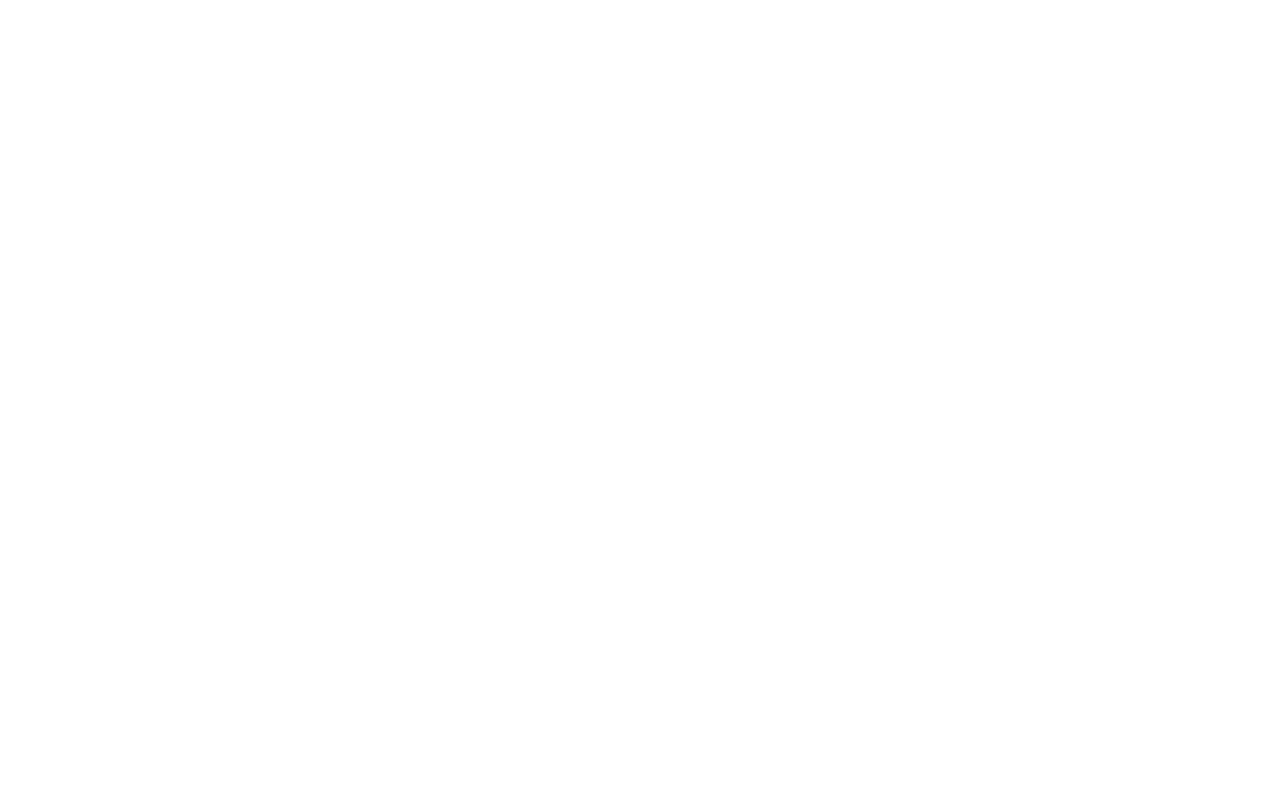
Frontiers in Surgery |